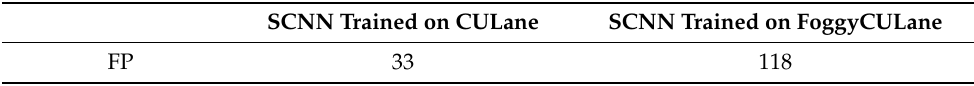
Table 6. Lane detection results (FP) of SCNN in real foggy